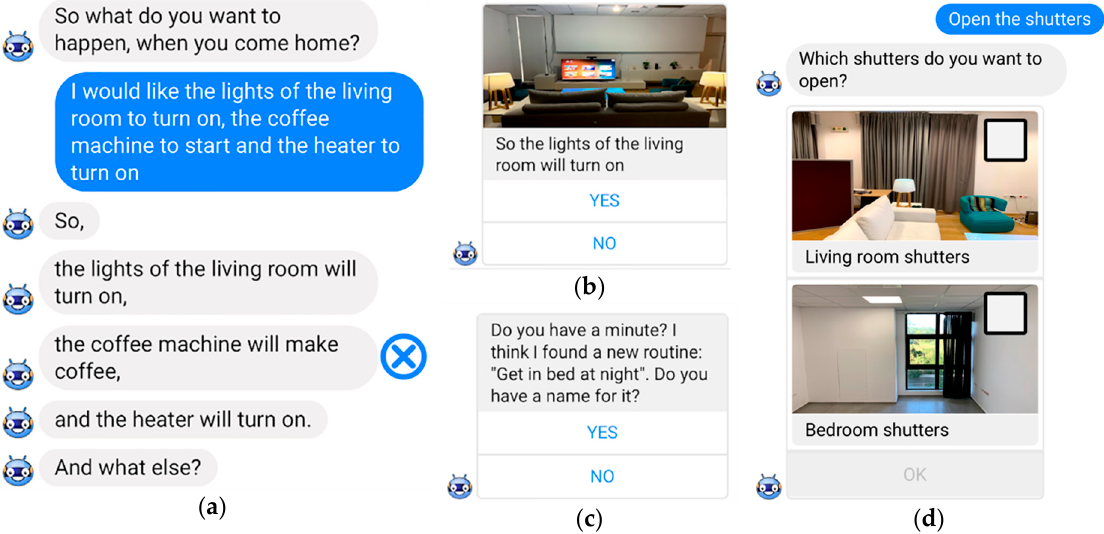
Figure 7. Mechanisms of ParlAmI as employed by MAI: ( a ) message decomposition; ( b ) confirmation mechanism; ( c ) hiding complexity; ( d ) exploitation of contextual information.